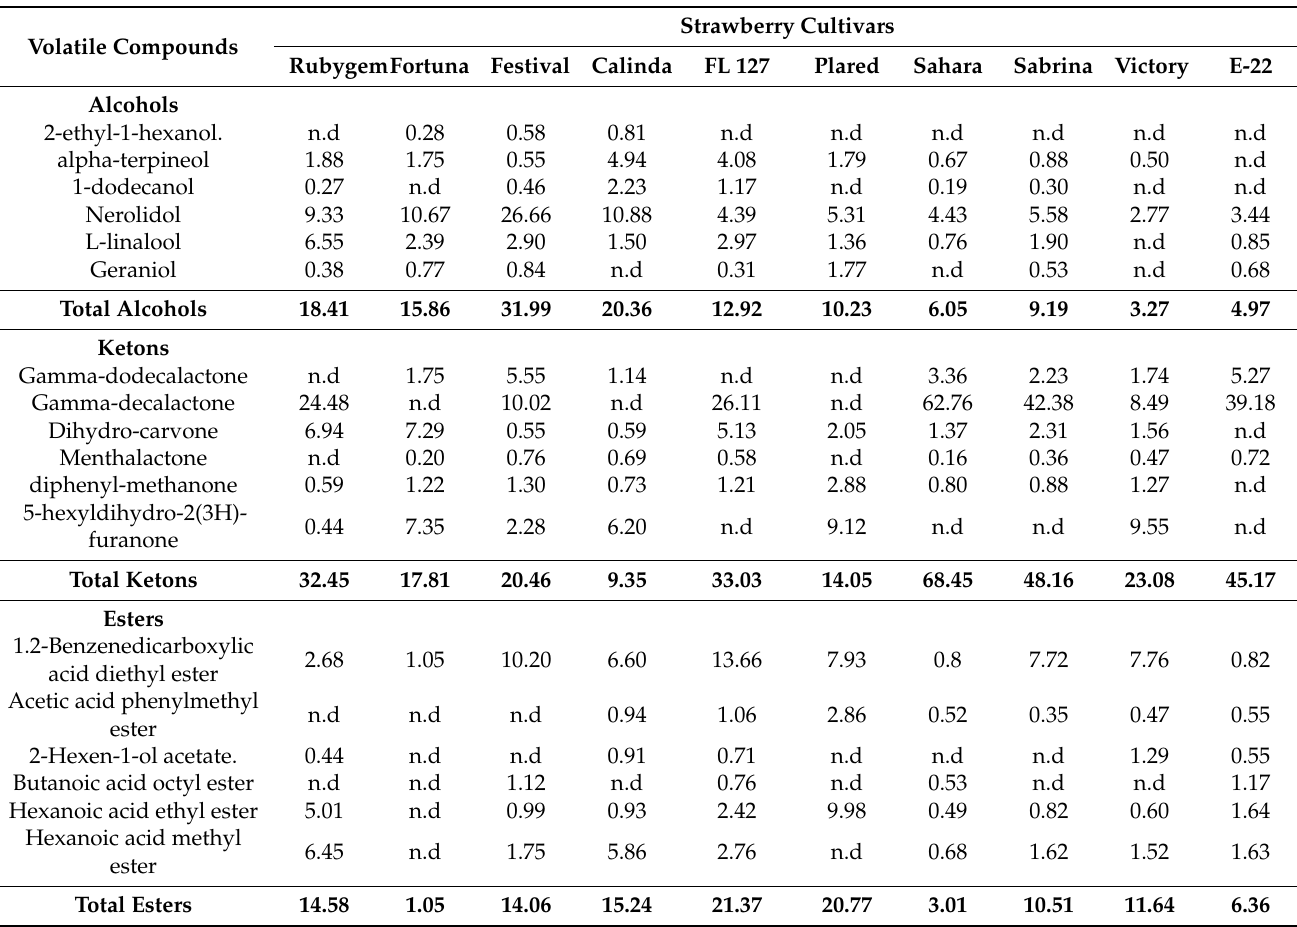
Table 5. The volatile compounds ( µ g kg − 1 ) in fruits of ten strawberry